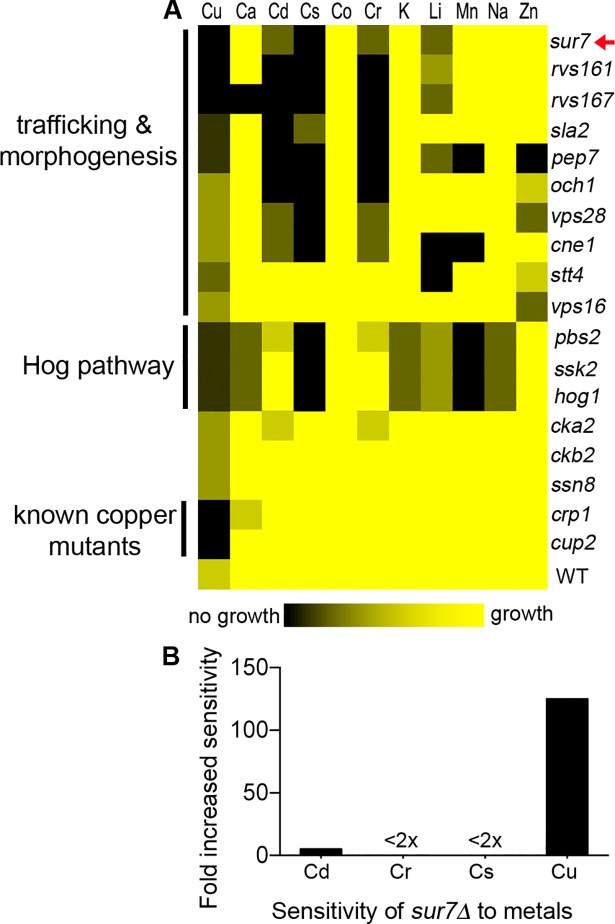
Genes that function in stress response, morphogenesis, and membrane trafficking influence copper resistance.(A) C. albicans strains were replica-plated onto minimal synthetic media containing copper or another indicated metal, and then the extent of growth was recorded and summarized in a heat map. The mutant strains clustered into three major groups. The sur7Δ mutant clustered with other mutants known to be defective in trafficking and morphogenesis, a separate cluster included the HOG1 pathway mutants that are sensitive to stress, and the known copper mutants crp1Δ and cup2Δ clustered. The results represent a compilation of three experiments for each metal performed on different days. (B) The sensitivity of sur7Δ to cadmium (Cd), chromium, (Cr), and cesium (Cs) was further tested by incubating cells in different concentrations of these metals in synthetic medium a 96-well plate, since replica-plating indicated some degree of growth inhibition in response to these metals. Results indicated that sur7Δ cells only showed strong sensitivity to copper. The graph represents the averages of two to three independent experiments performed on different days.